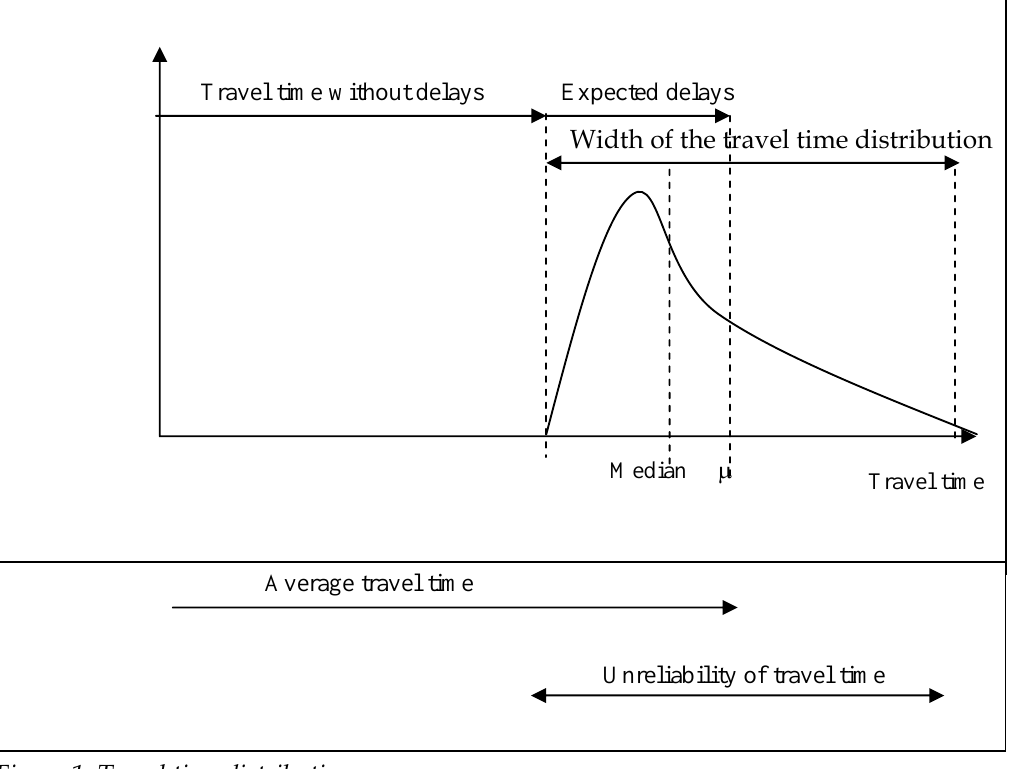
Figure 1. Travel time